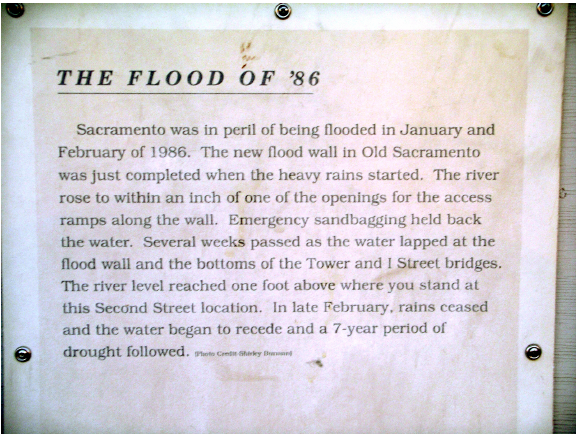
Fig. 5 . Public temporal reference to past flood, City of Sacramento Historic Landmark District (photo by